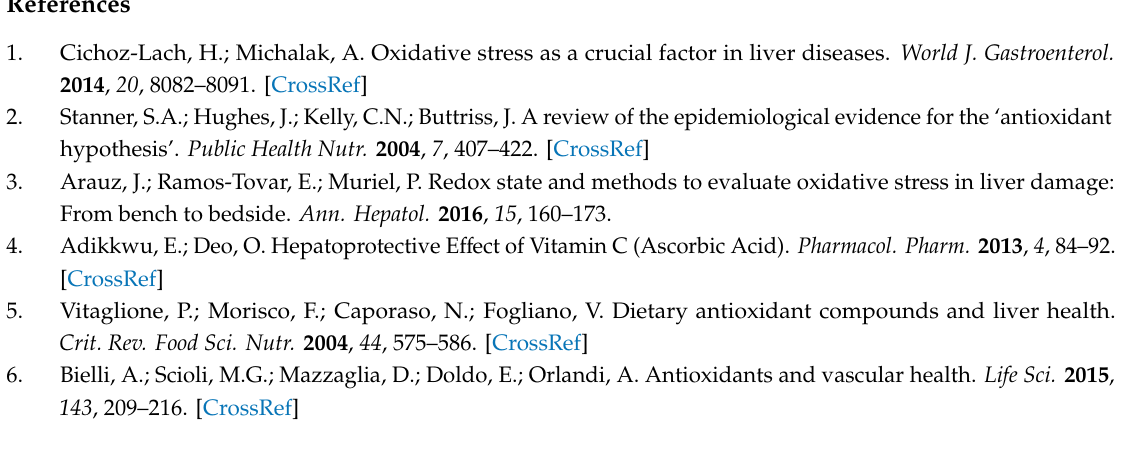
Figure S1: The main contribution of food items according to quartiles (Q) of dietary non-enzymatic antioxidant capacity estimated by ferric reducing-antioxidant power (FRAP) and oxygen radical absorbance capacity (ORAC), Table S1: Geometric means (95% CI) of serum liver enzyme levels according to quartiles (Q) of dietary overall NEAC estimated by ORAC, stratified risk factors of liver injury, Table S2: Geometric means (95% CI) of serum liver enzyme levels according to quartiles (Q) of dietary NEAC from foods estimated by FRAP, stratified risk factors of liver injury, Table S3: Geometric means (95% CI) of serum liver enzyme levels according to quartiles (Q) of dietary NEAC from foods estimated by ORAC, stratified risk factors of liver